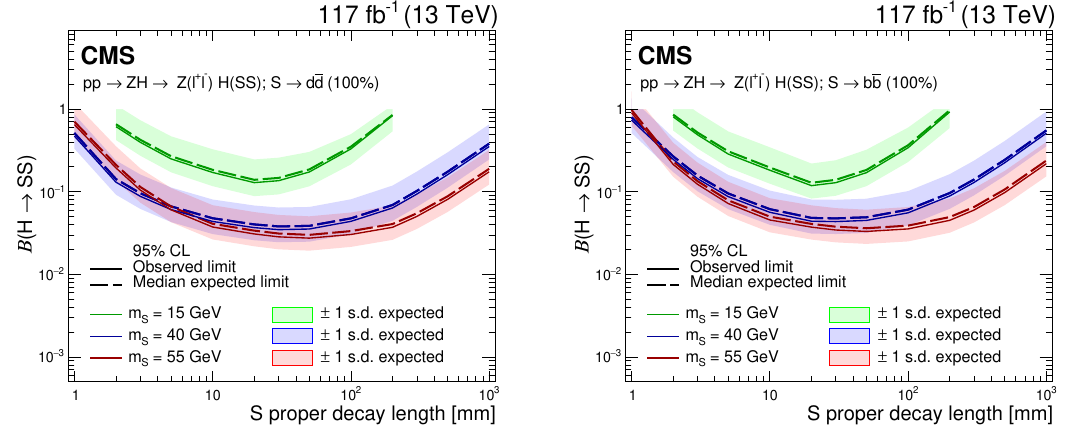
Figure 4 . Exclusion limits at 95% CL on the Higgs boson branching fraction to long-lived scalars B (H → SS) . Limits are presented for scalar decays to d quarks (left) and b quarks (right) as a function of the mean proper decay length of the scalar. The limits for the different scalar masses are shown in different colors for each scalar decay